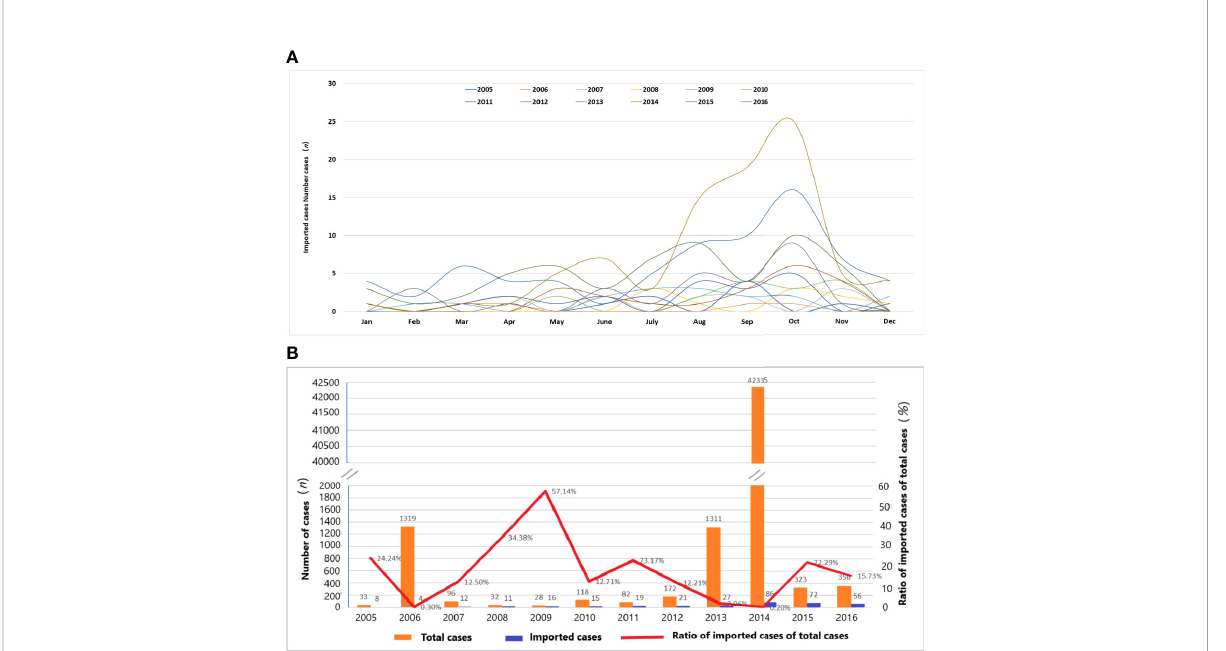
BA FIGURE 2 Temporal distribution characteristics of imported dengue cases from 2005 to 2016. (A) Time distribution of dengue imported cases. (B) Ratio of imported cases to total cases in each FIGURE 3 The in fl uence of imported cases on the epidemic of surrounding dengue. The imported case was set as the original point, and the high-density area for case distribution is 5,000 to 6,500 m from the imported case on distance and within 5 days on time of diagnosis of the imported case, with a potential dengue incidence of 0.0181%. The area on the distance within 1,000 m and on time longer than 15 days shows a low-density area of cases reported, with a potential dengue incidence of only 0.0021%.